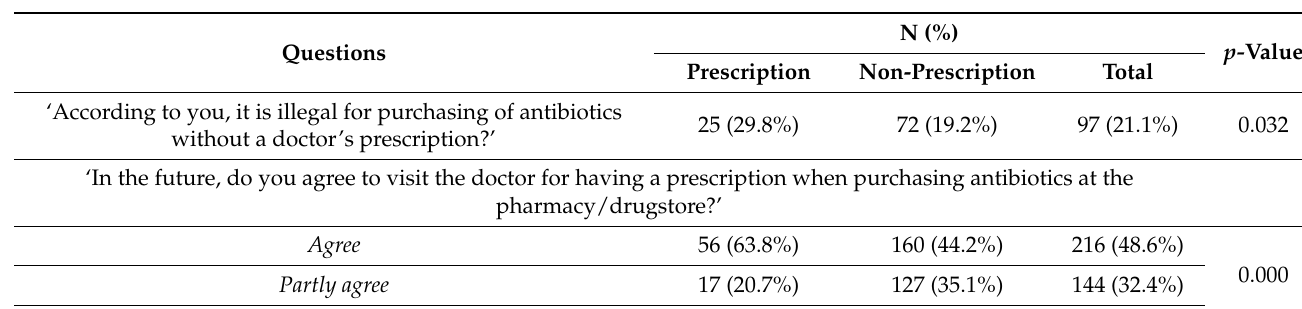
Table 4. Awareness of customers about antibiotics.